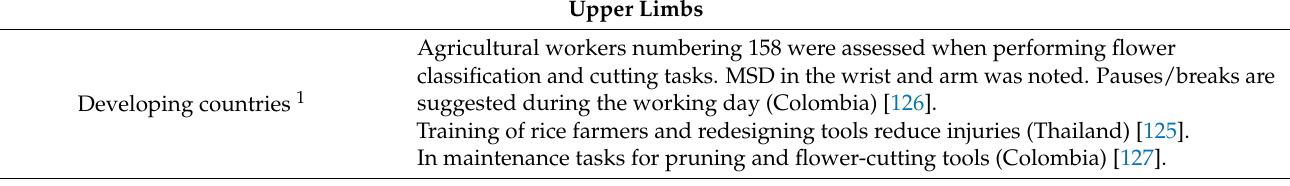
Table A5. MSD research in agriculture (1995–2020). Category: Upper limbs. Upper Limbs